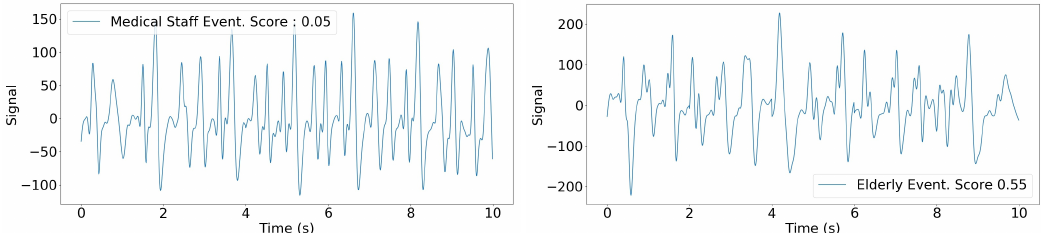
Figure 11. Examples of signals misclassified by N URSE N ET . ( Left ) Nurse pushing a wheelchair. Note that the signal is irregular. ( Right ) Elderly walking. Contrary to the previous example (Figure 9), this signal presents higher periodicity and amplitude, and the recorded individual is healthier. Table 3. Confusion matrix for different thresholds τ , i.e., activity is classified as staff if the network produces an output greater than or equal to τ . Note that the staff activities that are confused by the networks are essentially the nurse pushing medical material such as wheelchairs or carts on the sensor. Staff Elderly Single Walk Multiple Walks Other Single Walk Multiple Walks